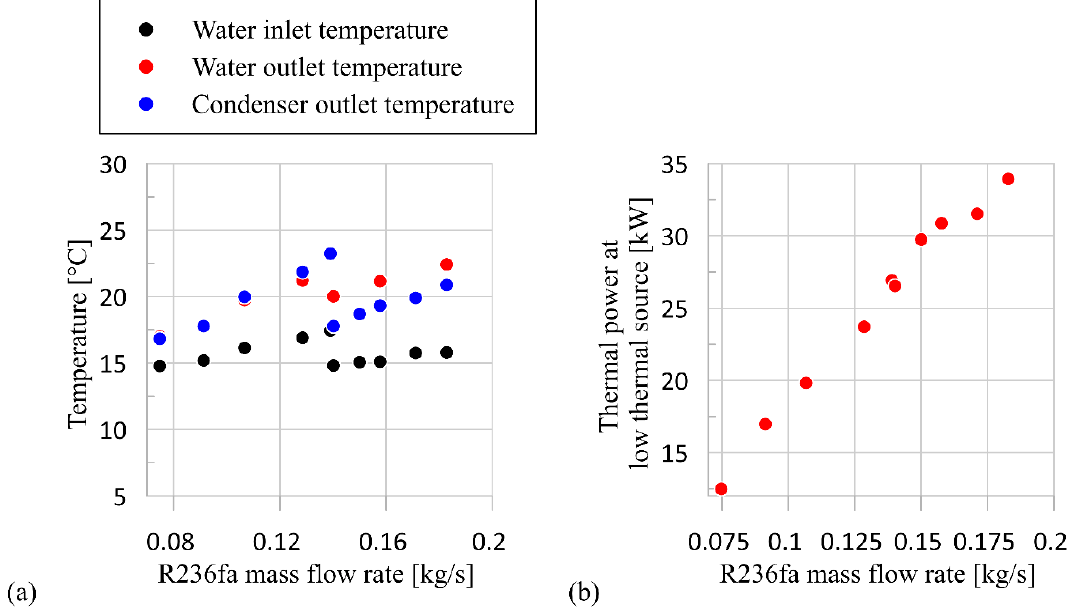
Figure 13. ( a ) R236fa inlet temperature and water inlet and outlet temperature at condenser, ( b ) Power at low thermal source.